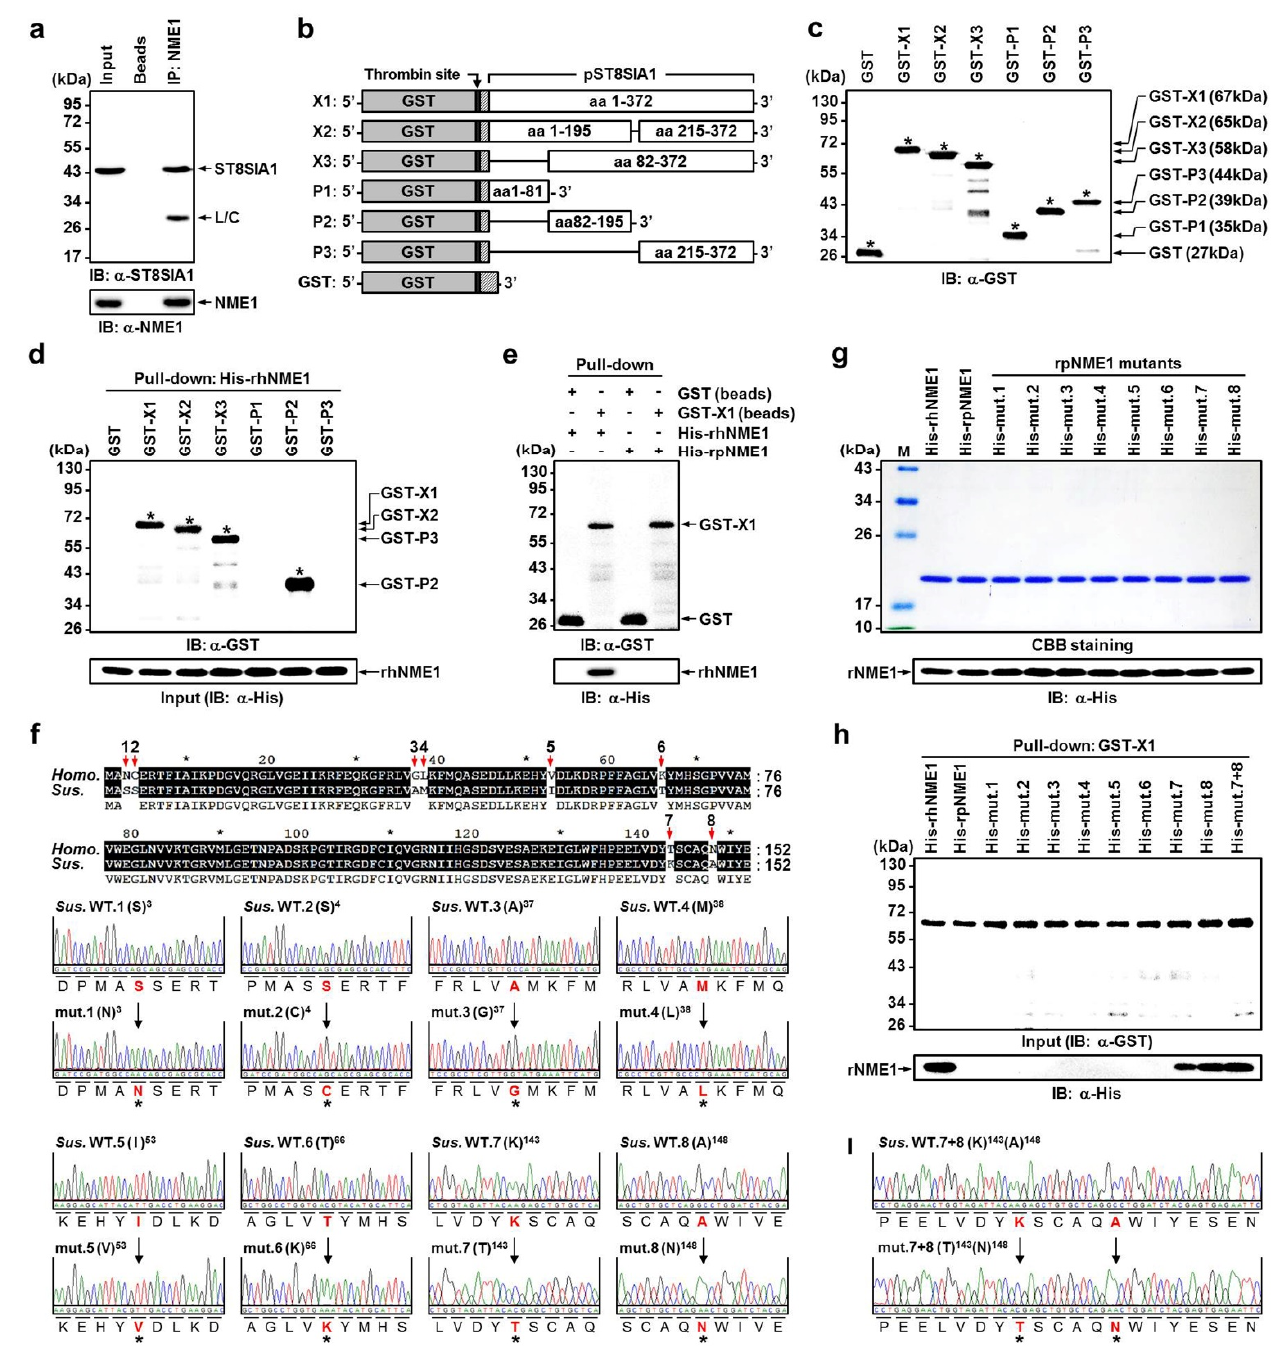
Figure 4. Identification of hNME1 as a novel pST8SIA1-binding protein using IP and pull-down assay. ( a ) NME1 interacts with ST8SIA1. U937 cells were lysed under non-denaturing conditions, and 500 μ g of total lysate protein was subjected to IP with α -NME1. Precipitated proteins were resolved by SDS-PAGE, and IB analysis probed for ST8SIA1 or NME1 as indicated. Arrows indicate immunoreactive bands; the precipitated ST8SIA1 band is denoted with an asterisk. Beads, beads only (IgG); L/C, light chain. ( b ) The rpST8SIA1 constructs. GST fusion proteins were generated by cloning PCR-amplified ST8SIA1 sequences into the pEX-N-GST expression vector. Domain structure of the full-length GST-ST8SIA1 protein and the various deletion mutants used. X1-3, transcript variants 1–3; P1–3, partial transcripts 1–3; aa, amino acids. ( c ) Equivalent amounts of purified recombinant GST, GST-ST8SIA1, or GST-ST8SIA1 deletion mutants were analyzed by SDS-PAGE followed by IB analysis with the specific α -GST antibody. ( d ) GST pull-down assay on purified-His-rhNME1 incubated with equivalent amounts of GST, GST-X1, GST-X2, GST-X3, GST-P1, GST-P2, and GST-P3. Results were analyzed by SDS-PAGE followed by IB analysis with the specific α -GST and α -His antibody. The ST8SIA1 domains bound by NME1 are denoted with an asterisk. ( e ) GST pull-down assay on His-rhNME1 or purified-His-tagged recombinant porcine NME1 incubated with equivalent amounts of GST and GST-X1 beads. Results were analyzed by SDS-PAGE followed by